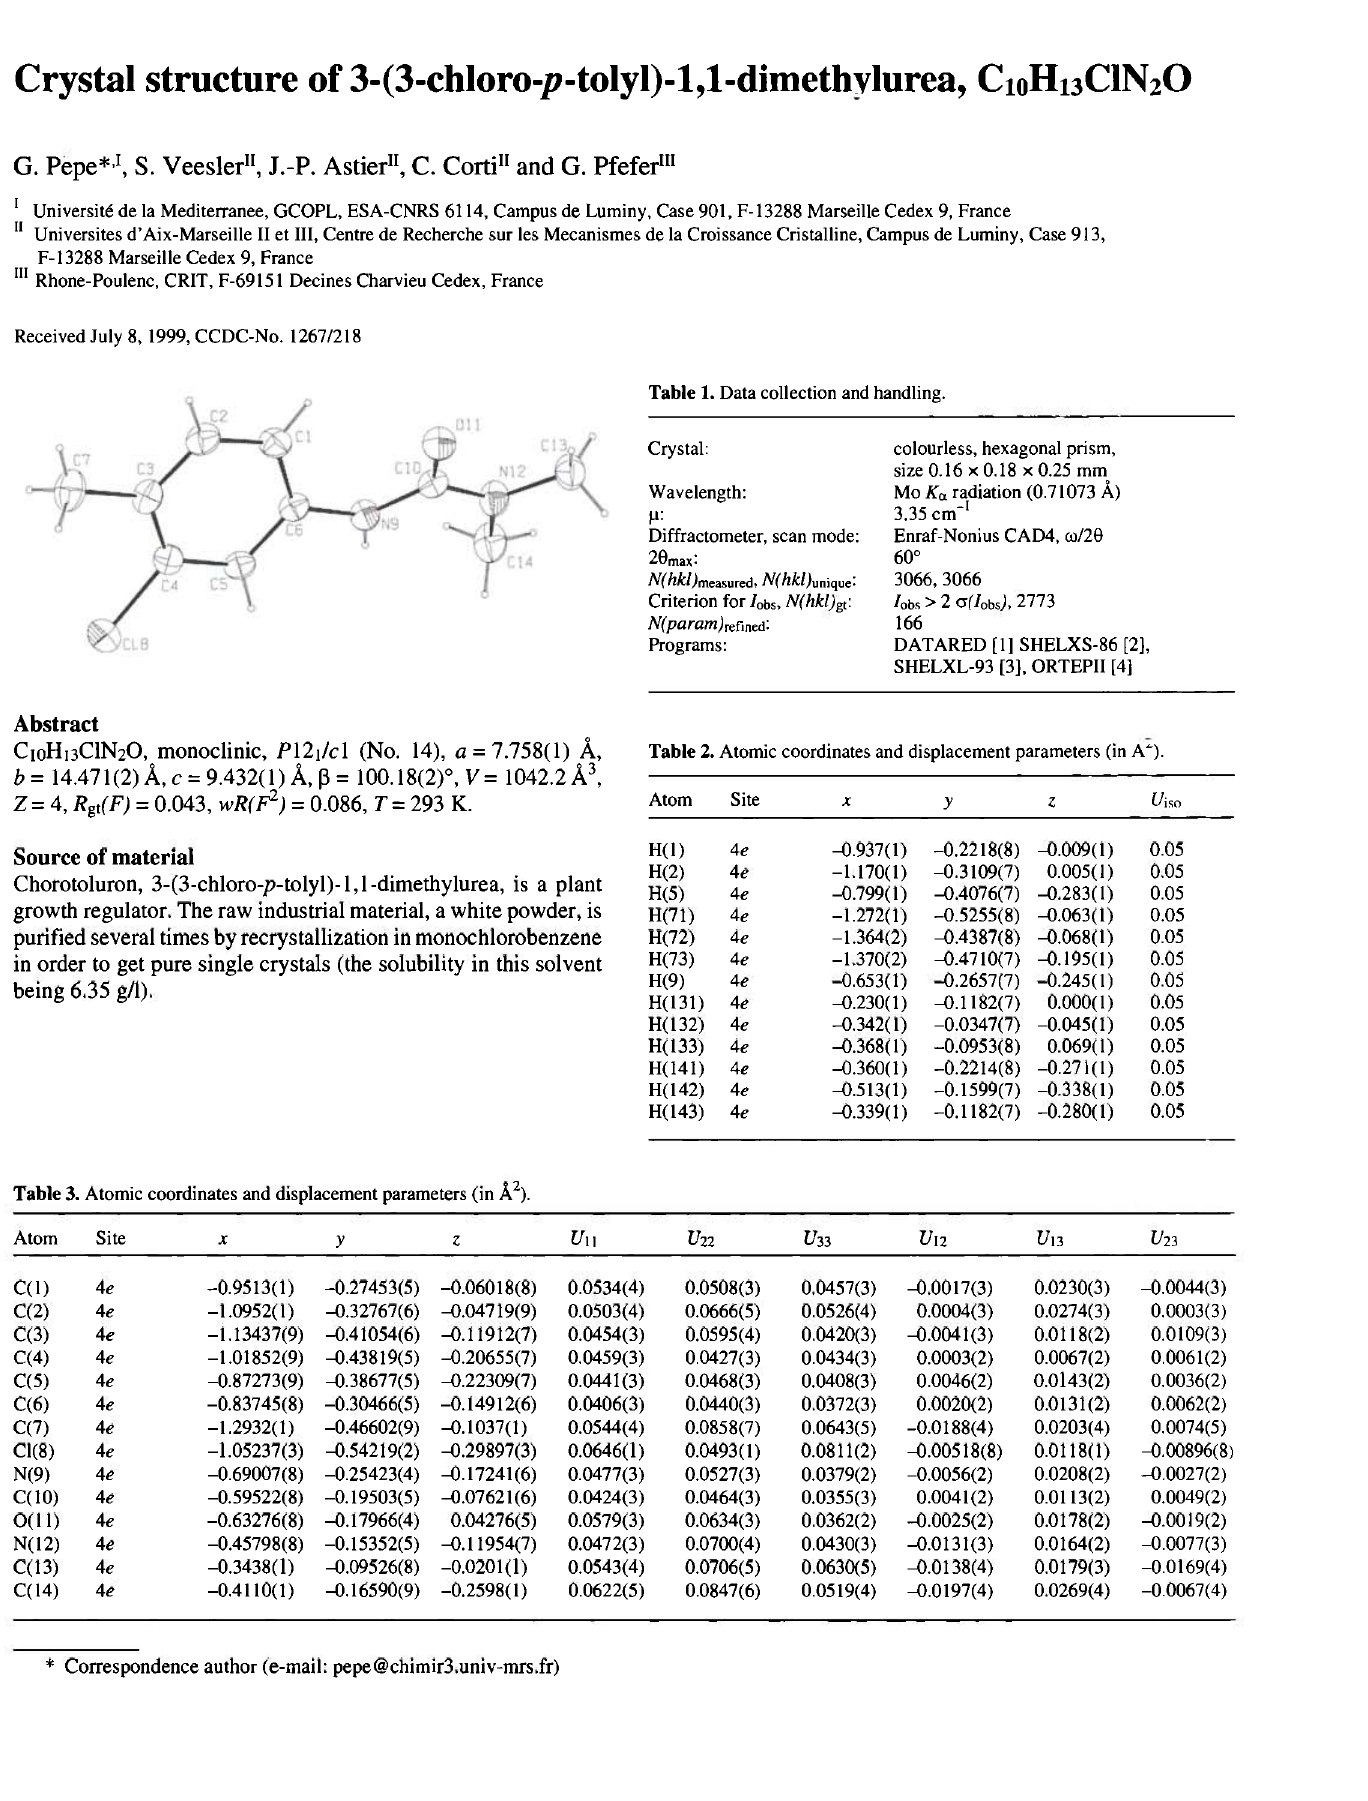
Table 3. Atomic coordinates and displacement parameters (in A 2